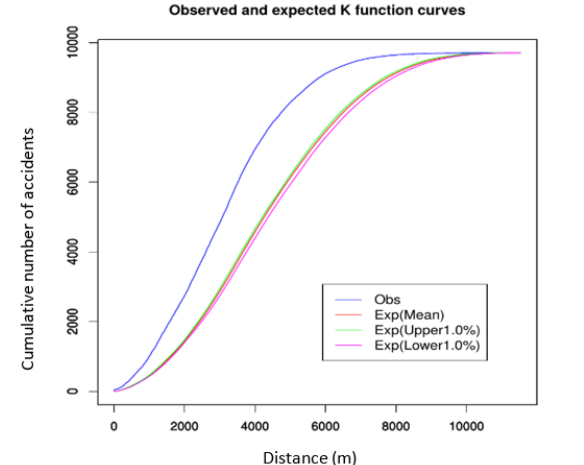
Figure 11. Network K-Function Analysis for the damage